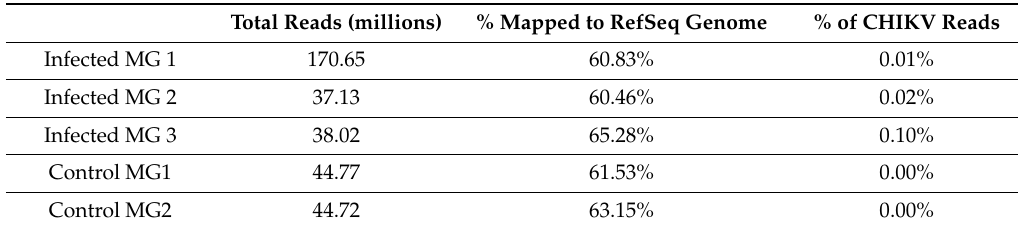
Table 1. RNASeq next-generation sequencing (NGS) data summary. The total number of obtained reads, the reads’ alignment percentage to the reference genome and the percentage of reads aligned to the chikungunya virus genome.